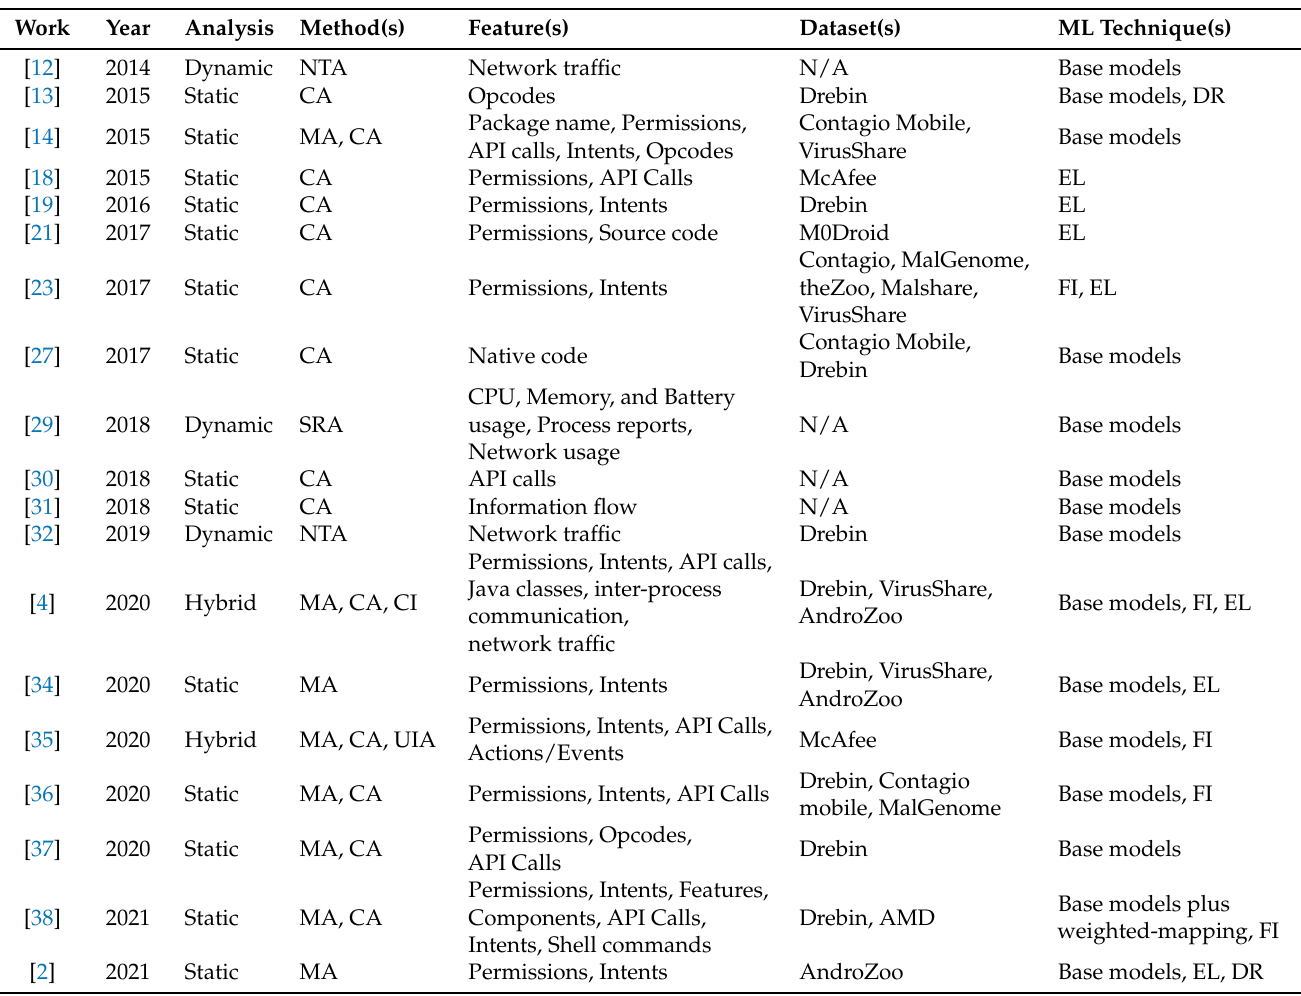
Table 3. Outline of the surveyed